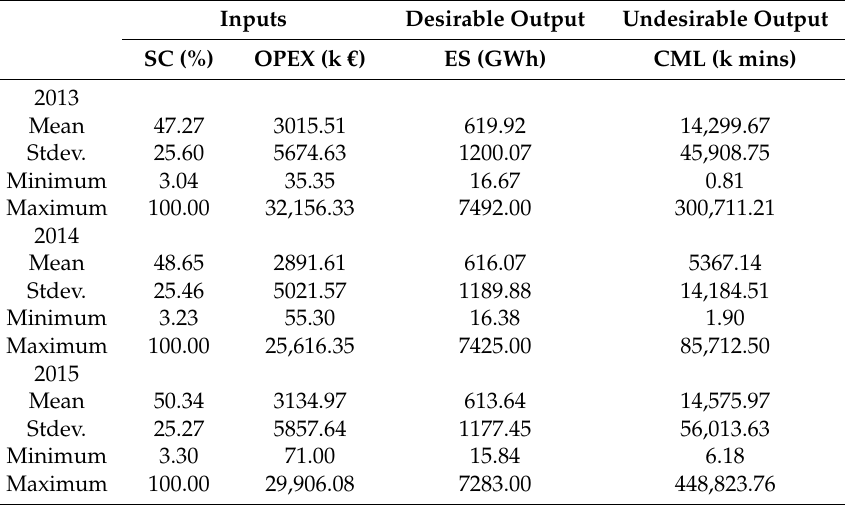
Table 1. Descriptive statistics for the pooled sample observations,